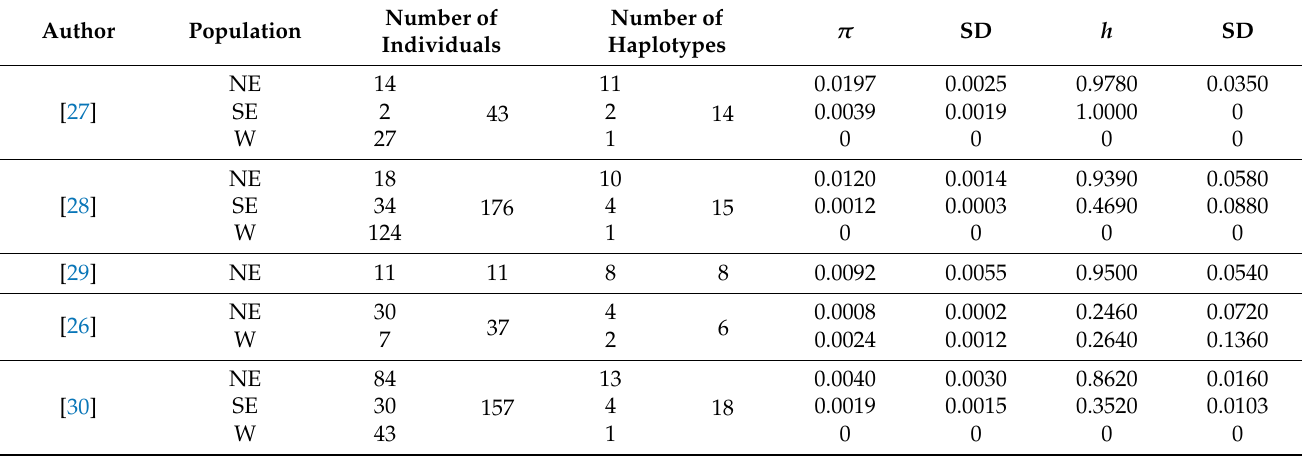
Table 1. Genetic diversity measures reported in the studies used in the meta-analysis performed in the present study (population abbreviations are as described in the main